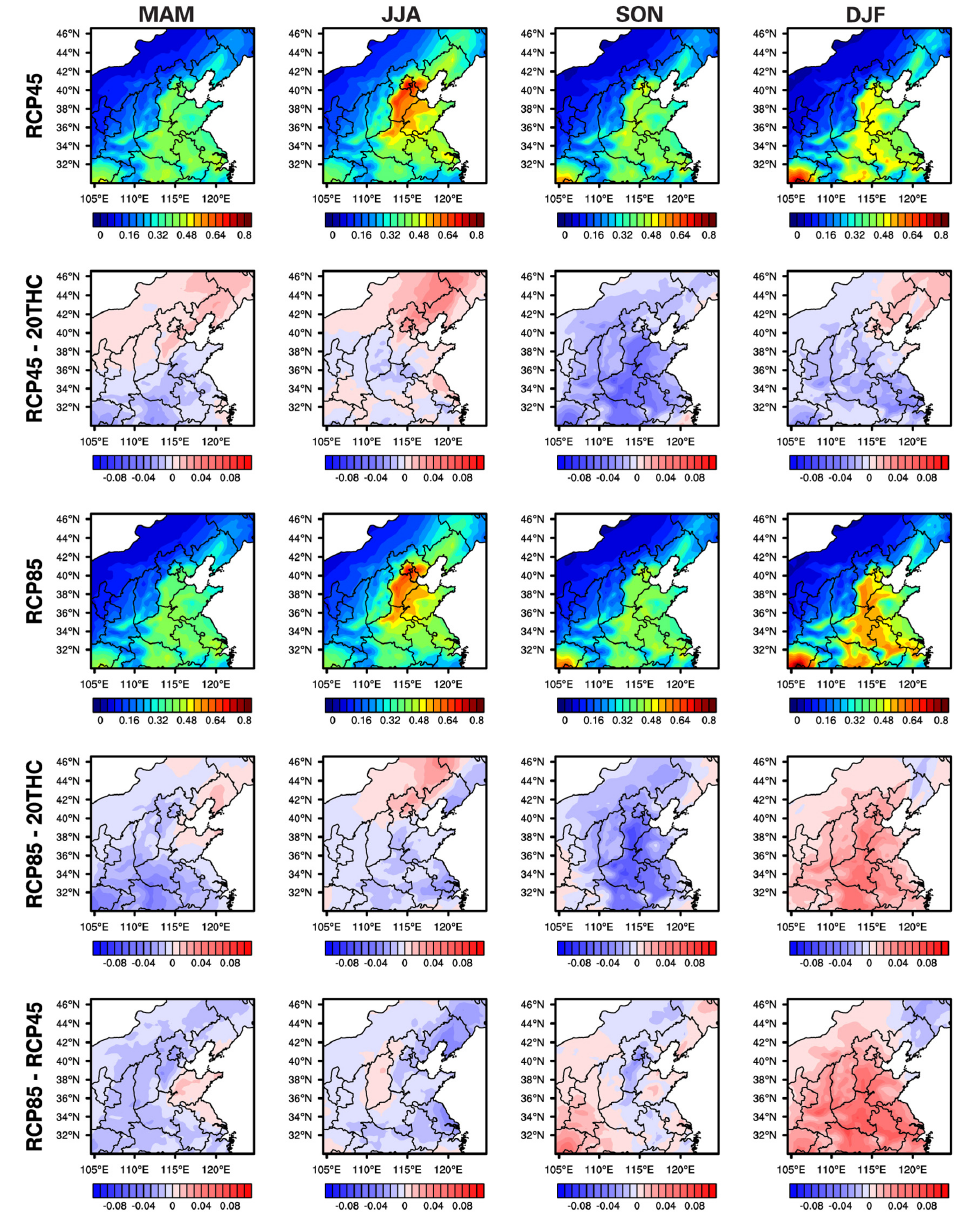
Figure 6. Averaged AOD in MAM, JJA, SON, and DJF in the RCP4.5 and RCP8.5 scenarios, and their changes relative to historical period. Figures in the bottom are represented the differences of AOD between the RCP8.5 and RCP4.5 scenarios.